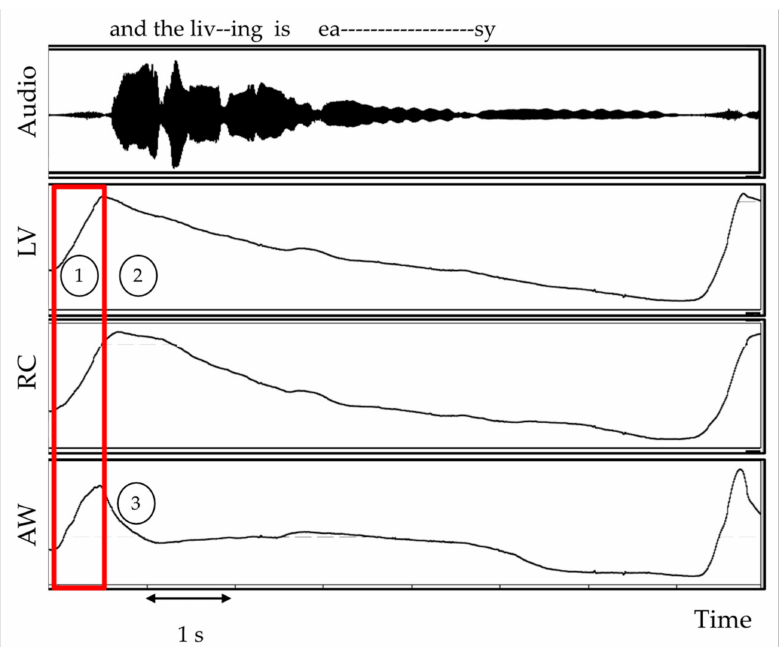
Figure 3. Audio, lung volume (LV), ribcage (RC) and abdominal wall (AW) signals from a phrase of “Summertime” (G. Gershwin), as sung by a female jazz singer and recorded by an omnidirectional microphone and the RespTrack System. Respiratory signals are displayed by the software Sopran (by S. Granqvist, www.tolvan.com, accessed on 6 September 2021): (1) inhalation; (2) phonation; (3) abdominal wall contraction, see